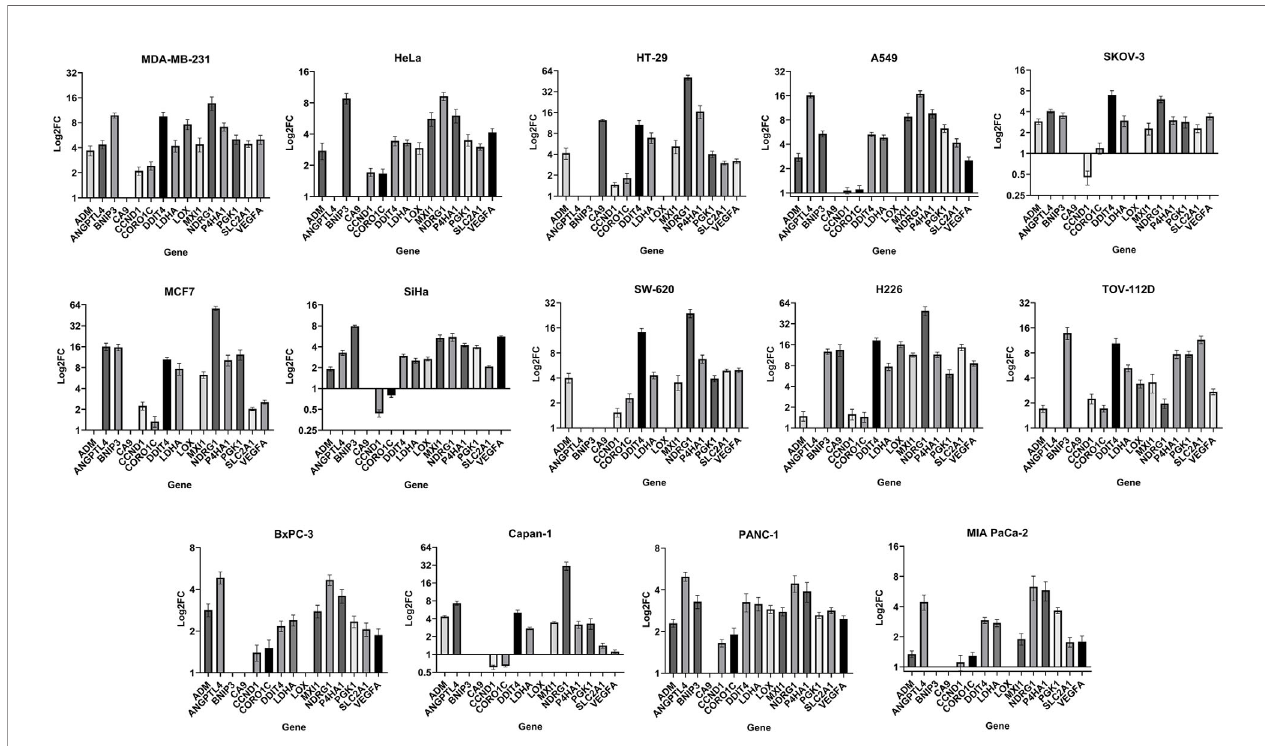
FIGURE 1 | Gene expression fold change in fourteen cancer cell lines: LogFC (fold change) of gene expression in hypoxia (1% O 2 ) relative to normoxia (21% O 2 ) reported as mean ± SEM (standard error of mean) of three independent experiments. Absence of a FC value indicates absence of gene expression or negligible expression in normoxia, preventing normalization and calculation of FC ( Supplementary Figure S1B